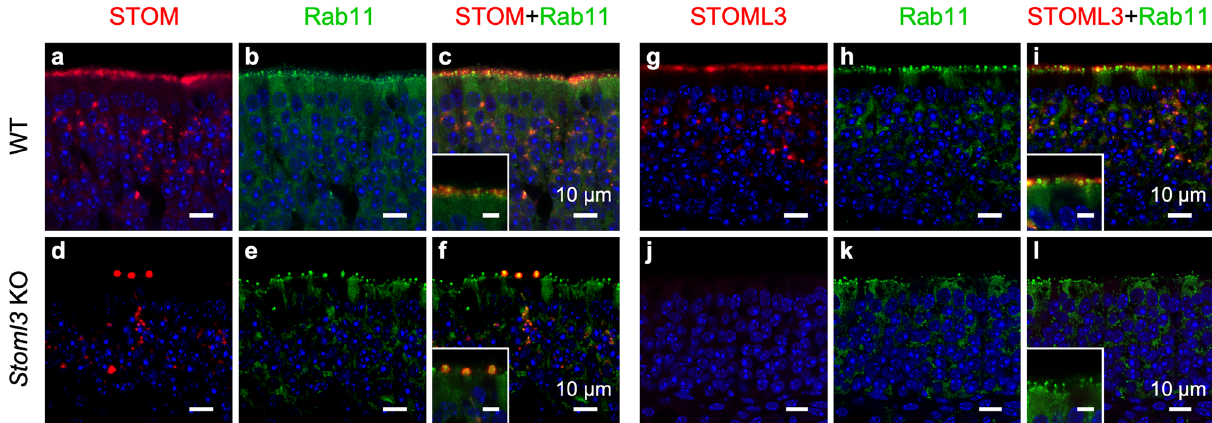
Figure 9. STOM and STOML3 co-localize with the endosomal marker Rab11. Single optical plane confocal micrographs of coronal sections of the OE of WT and Stoml3 KO mice stained with antibodies against STOM ( a and d , red) or STOML3 ( g and j , red). The same slices were double-stained with anti-Rab11 ( b , e , h , and k , green). As described before, STOM and STOML3 mainly localize in the cilia (see insets) and in puncta in the cell body of OSNs. Rab11 is scattered throughout the OE, although it looks particularly enriched apically in the knobs of OSNs (b , e , h , and k) where both STOM ( a , d , c and f ) and STOML3 ( g , j , i and l ) localize. Nuclei were stained with DAPI (blue). Insets scale bar 10